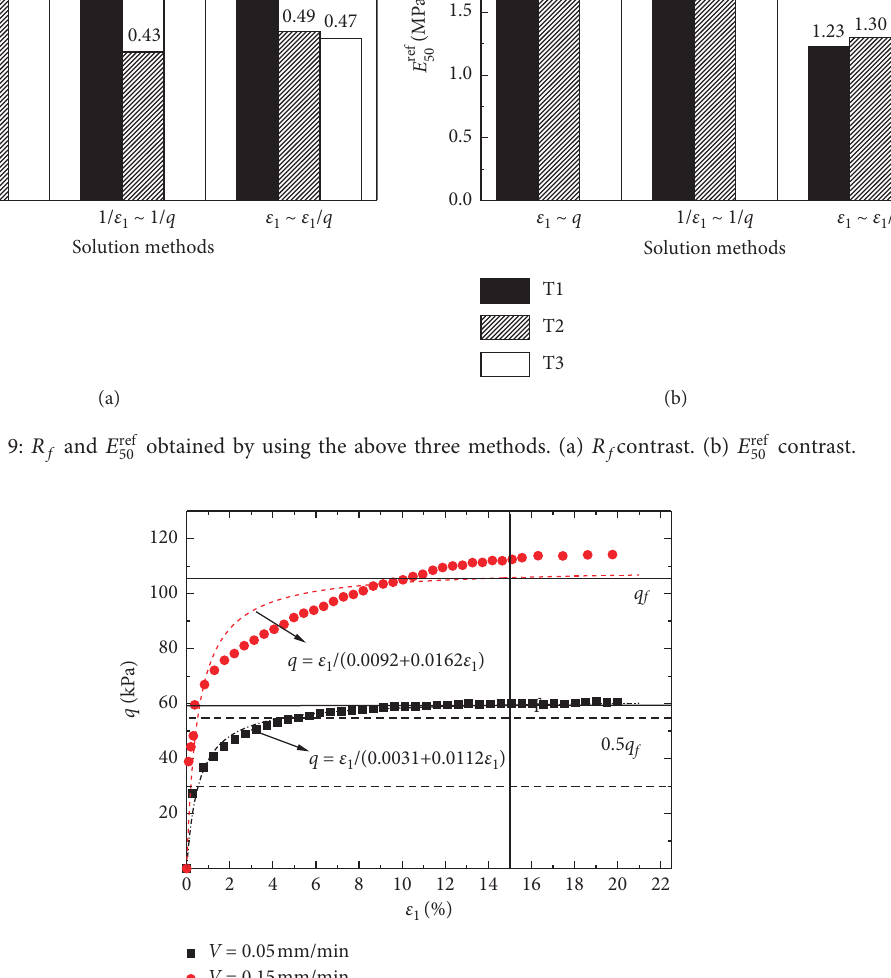
Figure 10: ε ∼ q curve based on different shear rates in CU 1